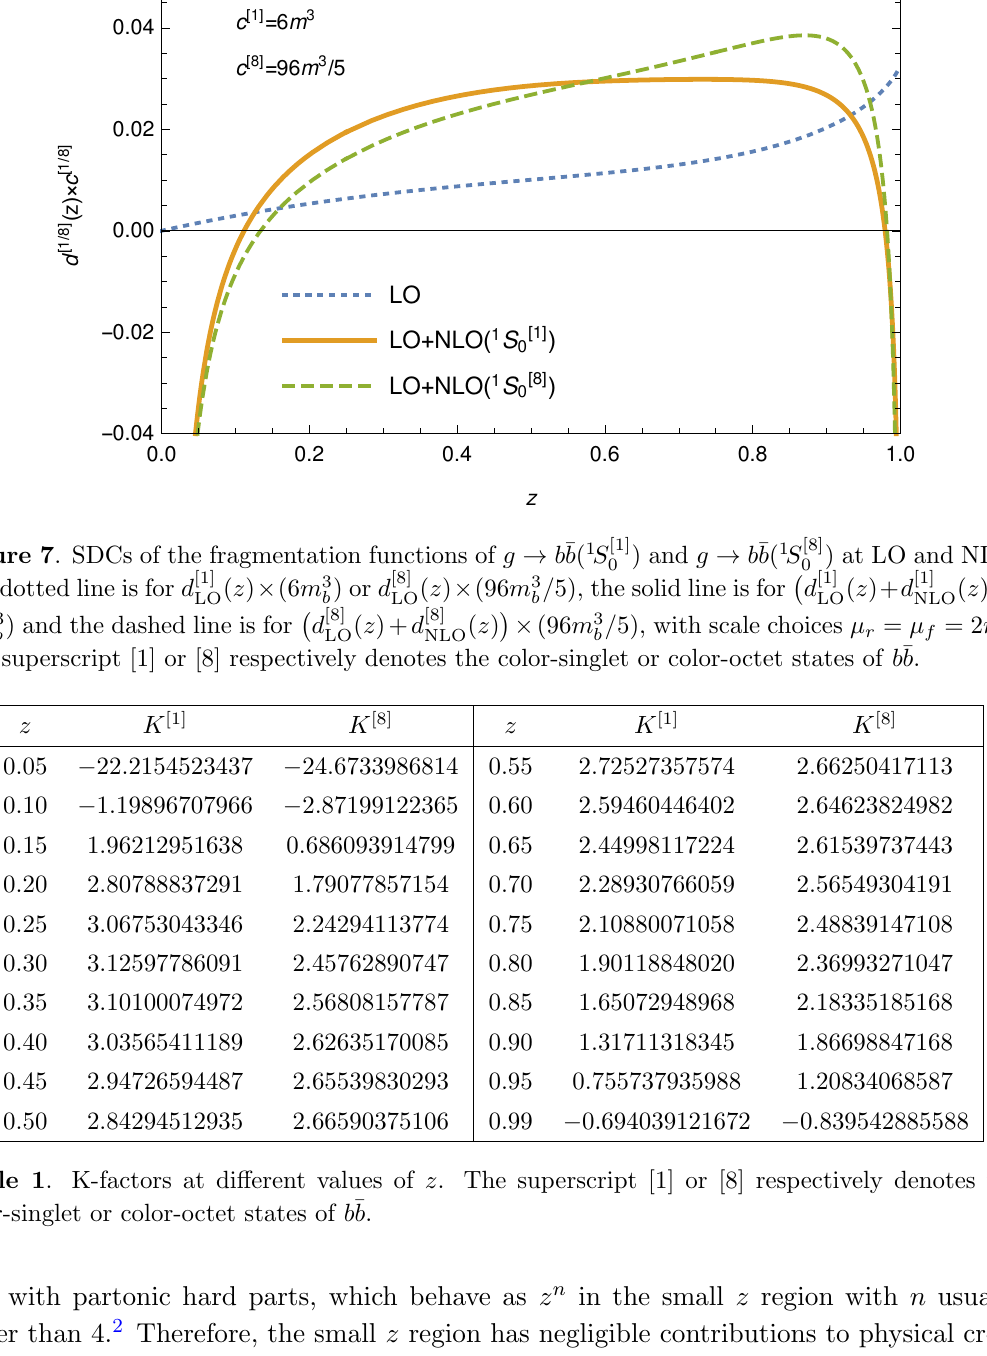
Table 1 . K-factors at di(cid:11)erent values of z . The superscript [1] or [8] respectively denotes the color-singlet or color-octet states of b (cid:22) b